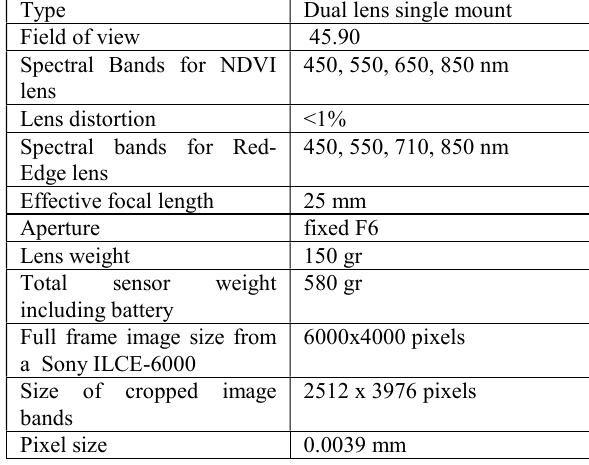
Table 1 Technical features of Agrowing sensor (Agrowing,